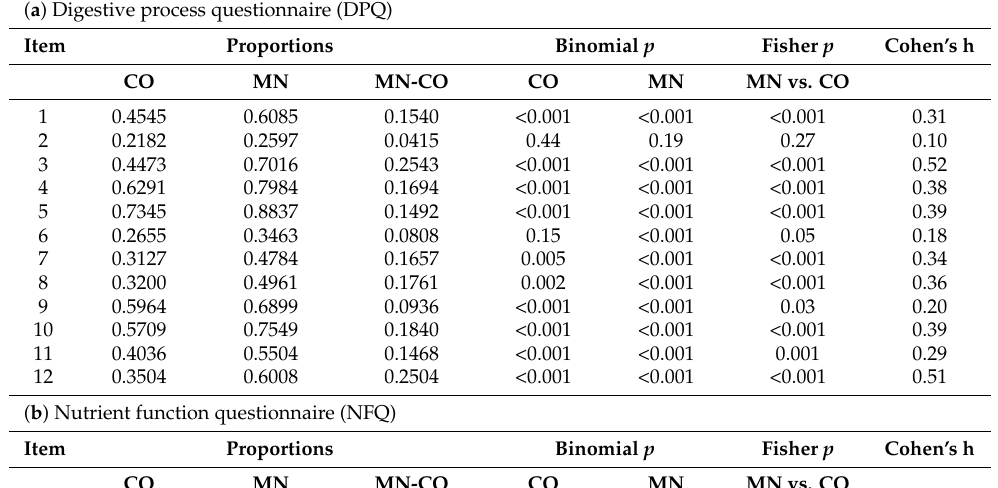
Table 2. Proportion of students giving the correct answers to the various questions of the three